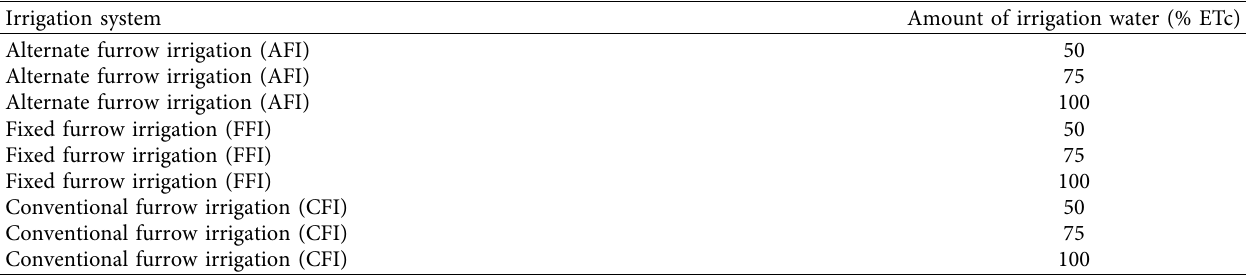
Table 1: Treatments setting for the field